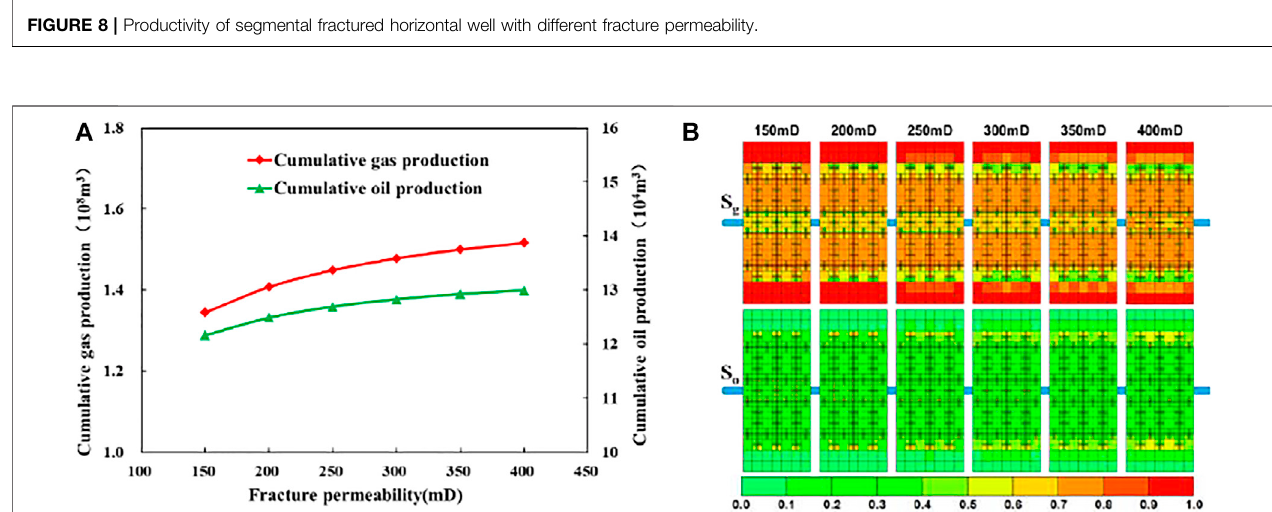
FIGURE 9 | Cumulative condensate and gas production curves (A) and oil and gas saturation distribution of fracturing segment (B) under different fracture permeability.